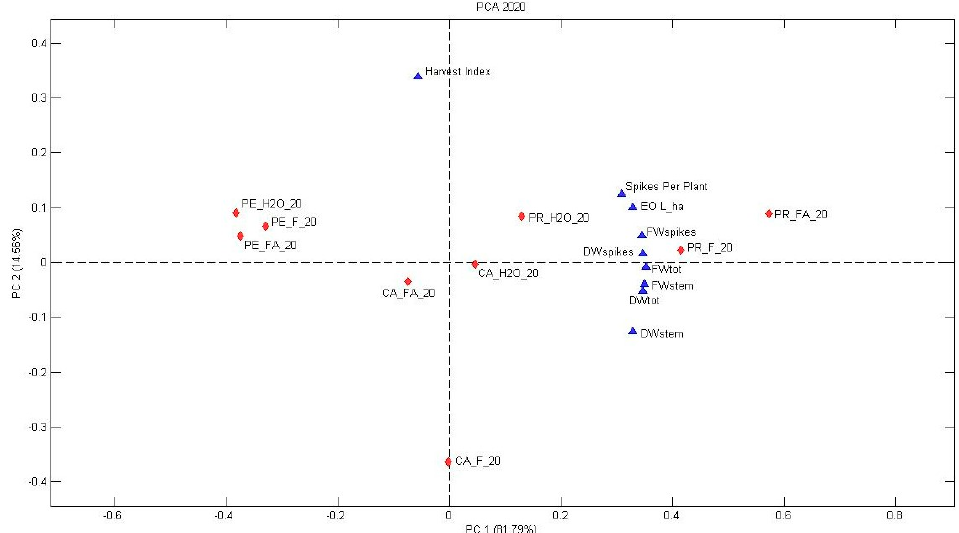
Figure 2. Principal component analysis (PCA) biplot of the morphological data from 2010/2020. CA, Campazzo; PE, Pedroni; PR, Preci; H2O, control with foliar application of tap water; F, foliar application of FITOSTIM; FA, foliar application of FITOSTIM ALGA; DW, dry weight; FW, fresh weight; EO L_ha, yield of essential oils (L ha − 1 ).